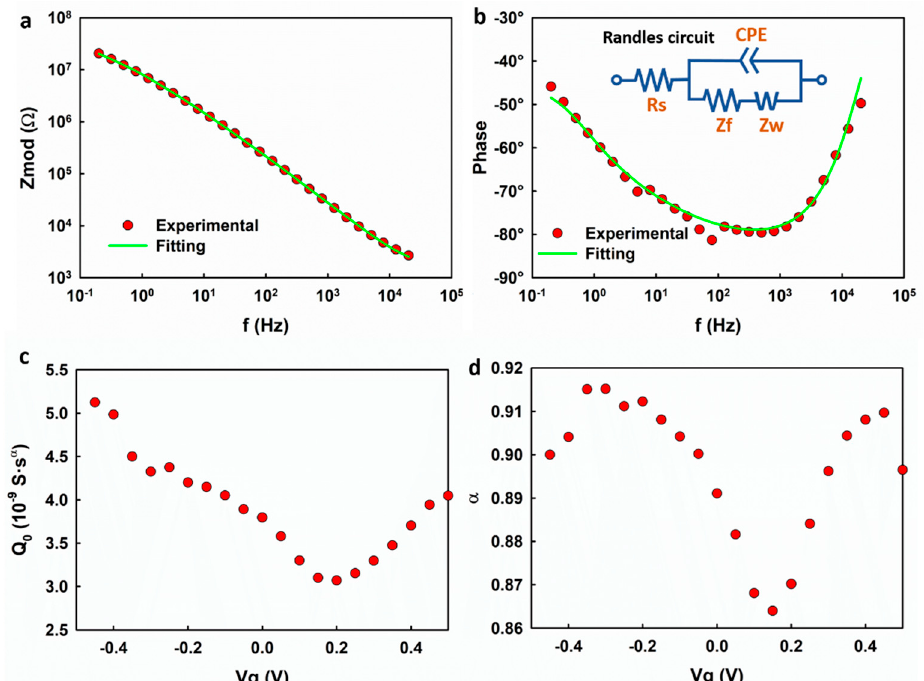
Figure 2. ( a , b ) The representative Bode plots of the graphene electrode and the fitting curve based on the Randles circuit; ( c , d ) the extracted Q 0 and α based on the Randles circuit. Note in (b): Rs represents the series resistance, including the access resistance and electrolyte resistance; CPE is the constant phase element; Z f is the faradaic impedance, and Z w is the Warburg impedance.